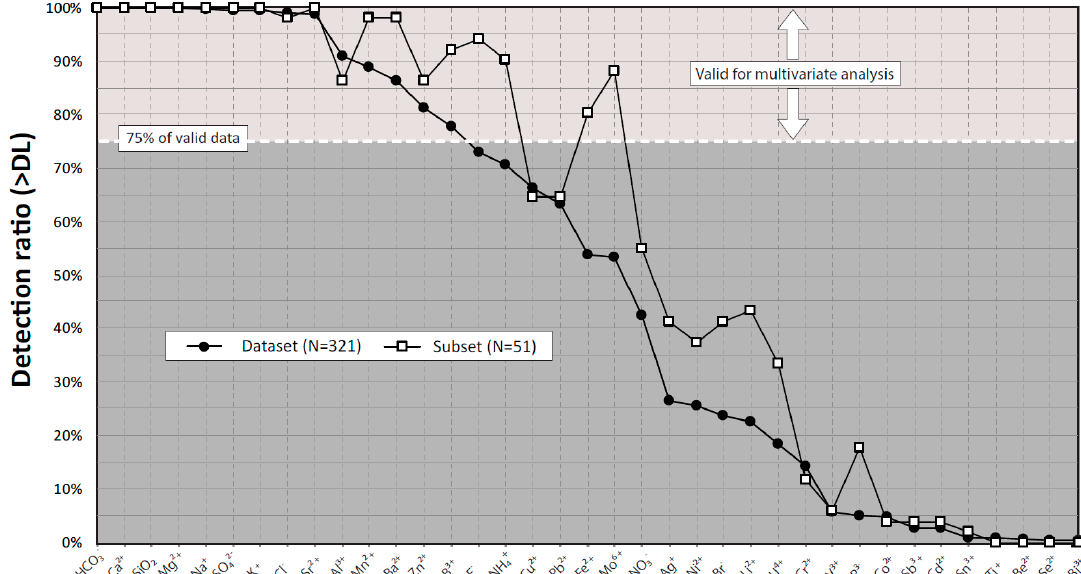
Figure 5. Comparison between the frequencies of detection of the chemical elements for the 321 sample dataset and the 51 sample subset.